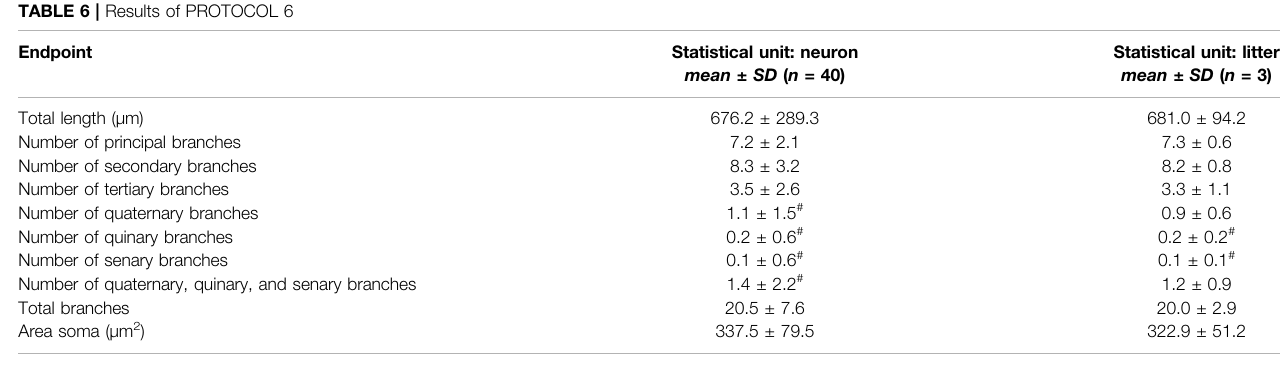
TABLE 6 | Results of PROTOCOL 6